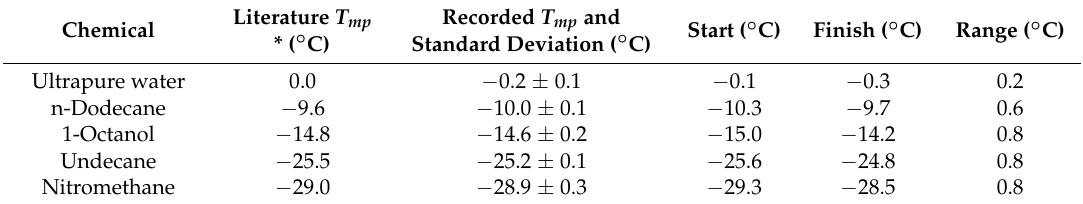
Table 2. Melting temperature ( T mp ) of solvents used for temperature calibration. Seven measurements were performed for each